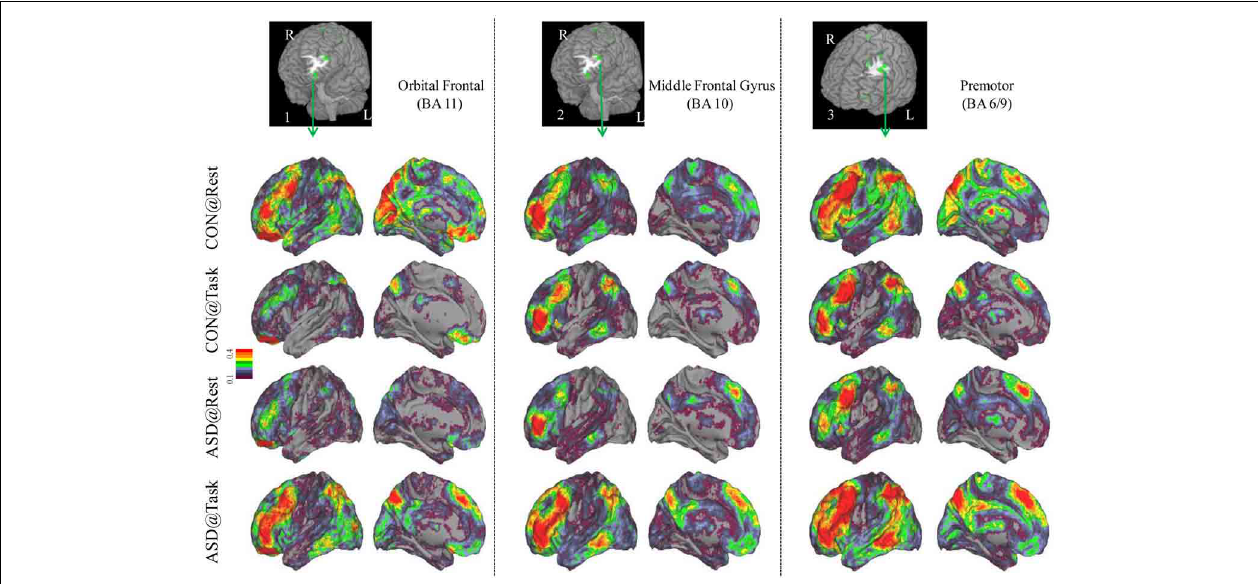
panel), left middle frontal gyrus (BA 10) (middle panel) and left premotor (BA 6/9) (right panel). Region numbers 1–3 on the left corner in the brain image correspond to the region number in Figure 1 .